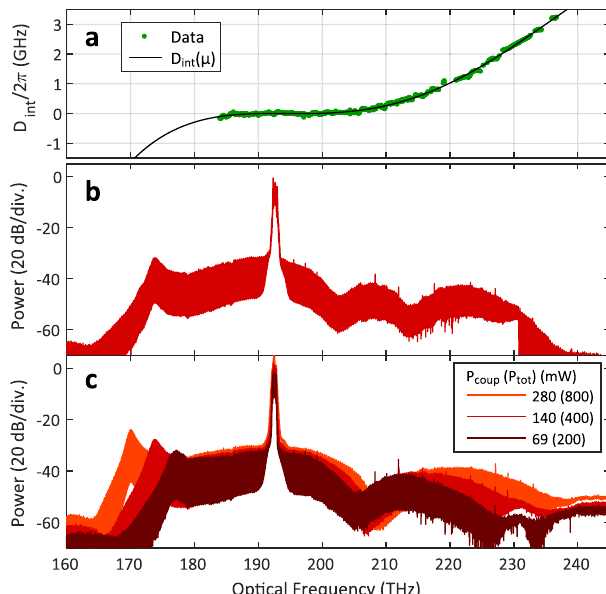
Fig. 6 | Experimental zero-dispersion soliton formation, MR2. a Experimental measurement of the resonator integrated dispersion D int , and spectrally extended fi tted solution. b ZDS (3) comb. c ZDS (2) combs, measured at maximum detuning using three pump powers, noted as effective average power coupled to ring (total power towards